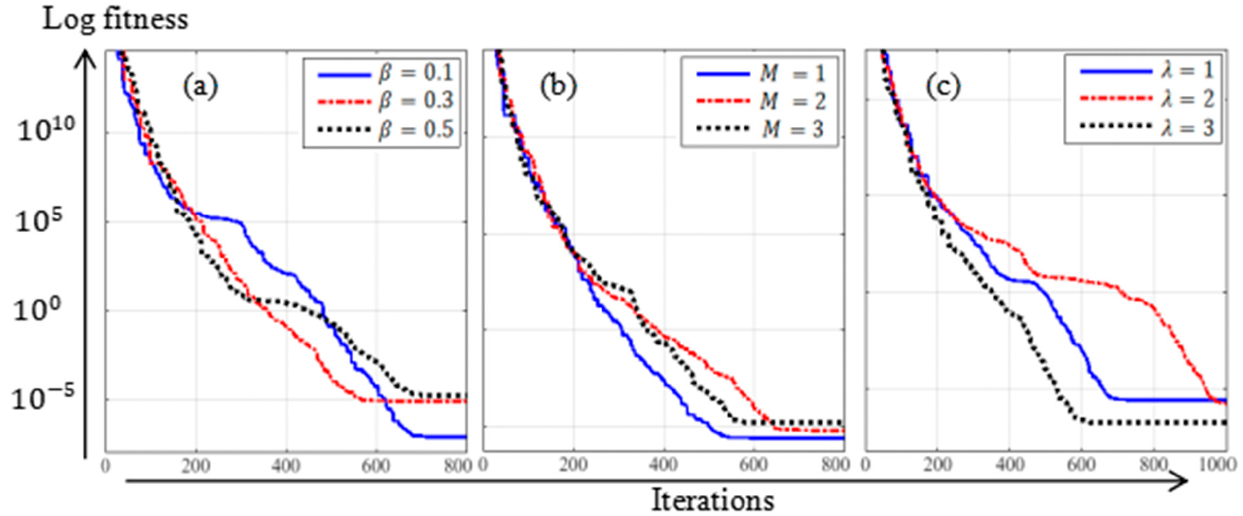
Figure 4. Convergence curves of optimization process for velocity profiles with respect to variations in ( a ) Casson fluid viscosity force parameter ( b ) Magnetic field parameter ( c ) Hartree pressure gradient parameter.